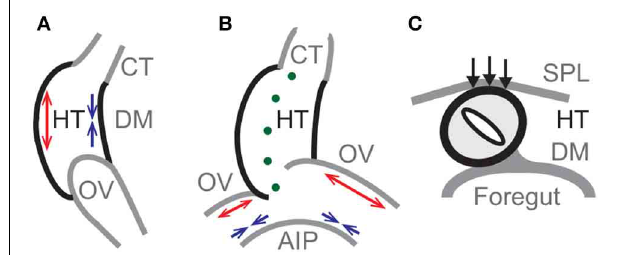
FIGURE 2 | Primary mechanisms in model for c-looping. Schematic diagrams of looping heart tube (HT) in (A) lateral, (B) ventral, and (C) cross-sectional views. (A) Bending of the HT is driven mainly by differential hypertrophic myocardial growth. Longitudinal growth causes the ventral side to elongate (red arrows), while the dorsal side shortens (blue arrows) with the dorsal mesocardium (DM) located at the inner curvature. (B) Asymmetric growth (red arrows) on the cranial sides of the omphalomesenteric veins (OVs) causes a slight rightward twist of the HT, as cytoskeletal contraction on the caudal sides (blue arrows) enhances the OV forces exerted on the HT. (Green dots indicate the original midline of the HT.) (C) The splanchnopleuric membrane (SPL) pushes the HT dorsally (black arrows) into its fully twisted position. AIP, anterior intestinal portal; CT,